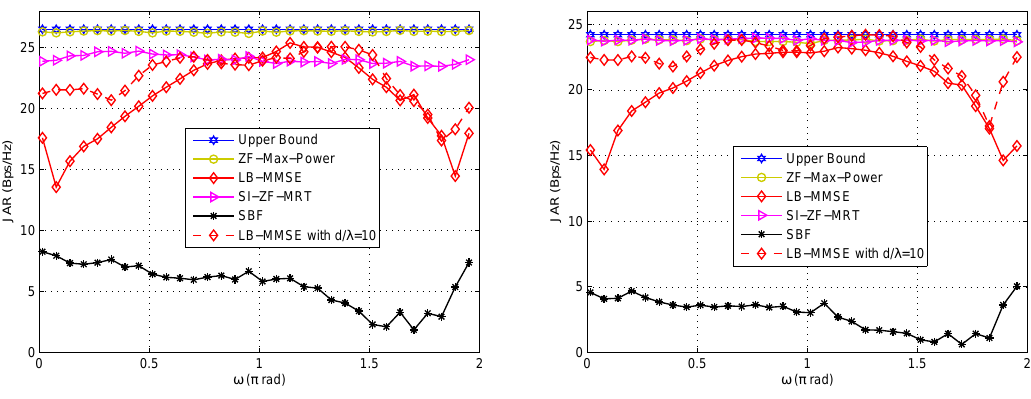
Figure 4. JAR performance of the involved schemes with respect to varying ω under LOS ( Left ) and NLOS ( Right ) channels in the case of separate arrays. ε 11 = ε 22 = 40 dB, ε 12 = ε 21 = 10 dB, d / λ = 2. For LB-MMSE, the JAR with d / λ = 10 is also